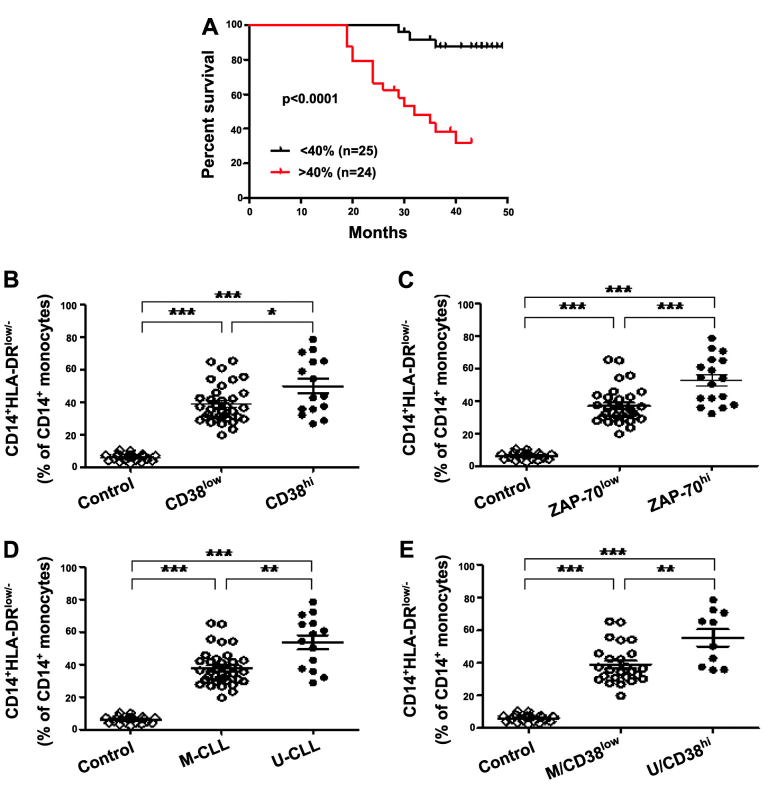
Upregulation of CD14+HLA-DRlow/− MDSCs predicts poor survival in CLL patients. (A) Kaplan-Meier curves of CLL patients with <40% (n=25) versus >40% (n=24) CD14+HLA-DRlow/− MDSCs in the CD14+ monocytes (log-rank test, P<0.0001). (B) Frequency of CD14+HLA-DRlow/− MDSCs in CD14+ monocytes of CLL patients stratified by CD38 expression levels compared with the control. A significantly higher frequency of CD14+HLA-DRlow/− MDSCs were identified in CD38high (n=15) and CD38low patients (n=34) compared with the healthy controls (n=21) (both P<0.0001). The CD38high subgroup tended to have higher frequency of CD14+HLA-DRlow/− MDSCs compared with the CD38low subgroup (P=0.0335). (C) A significantly higher frequency of CD14+HLA-DRlow/− MDSCs in CD14+ monocytes was identified in ZAP-70high (n=17) and ZAP-70low patients (n=32) compared with the healthy controls (n=21) (both P<0.0001), and the ZAP-70high subgroup exhibited a higher frequency than the ZAP-70low subgroup (P=0.0003). (D) A significantly higher frequency of CD14+HLA-DRlow/− MDSCs in CD14+ monocytes was identified in U-IGHV (n=14) and M-IGHV patients (n=35) compared with in the healthy controls (n=21) (both P<0.0001), and the ZAP-70high subgroup exhibited a higher frequency than the ZAP-70low subgroup (P=0.0019). (E) A significantly higher frequency of CD14+HLA-DRlow/− MDSCs in CD14+ monocytes was identified in U/CD38high (n=10) and M/CD38low patients (n=35) compared with in the healthy controls (n=21) (both P<0.0001), and the U/CD38high subgroup exhibited a higher frequency than the M/CD38low subgroup (P=0.0052). *P<0.05, **P<0.01 and ***P<0.001. CD14, cluster of differentiation 14; HLA, human leukocyte antigen; MDSCs, myeloid-derived suppressor cells; ZAP-70, ζ-chain-associated protein kinase-70; CLL, chronic lymphocytic leukemia; M, mutated; U, unmutated.